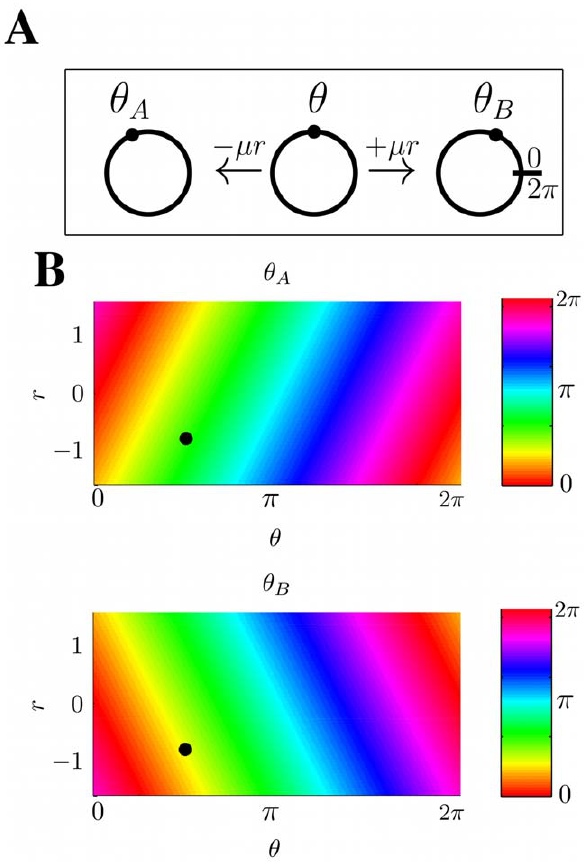
h (cid:8) p p . , 2 2